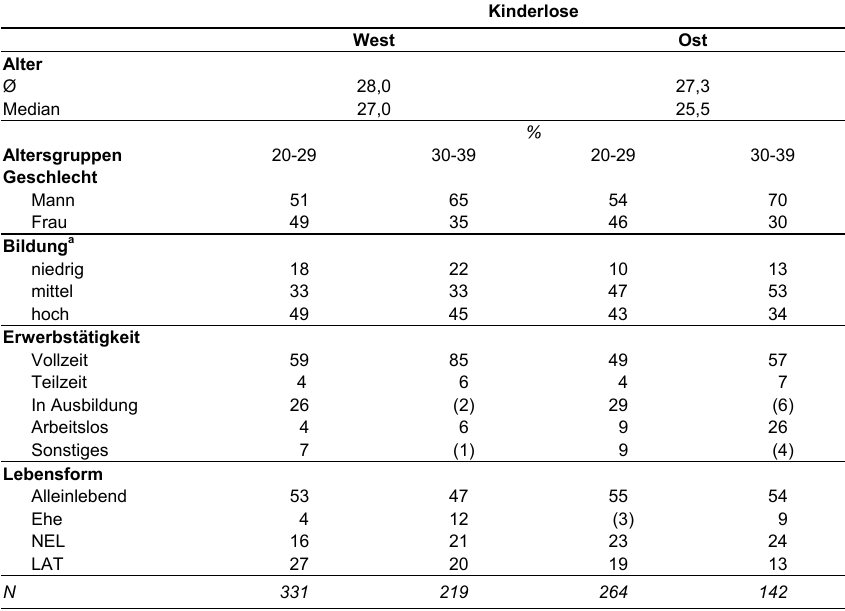
Ruckdeschel: Der Kinderwunsch von